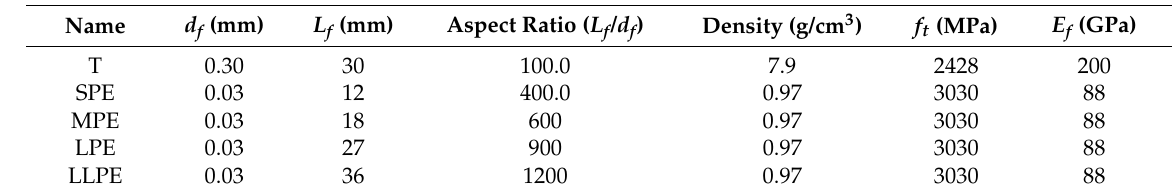
Table 4. Physical and mechanical properties of